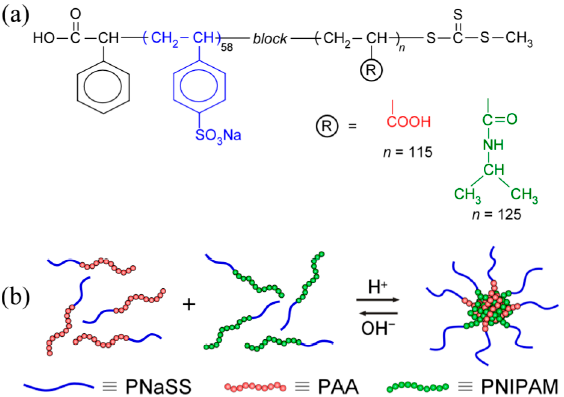
Figure 1. ( a ) Chemical structures of diblock copolymers used in this study: